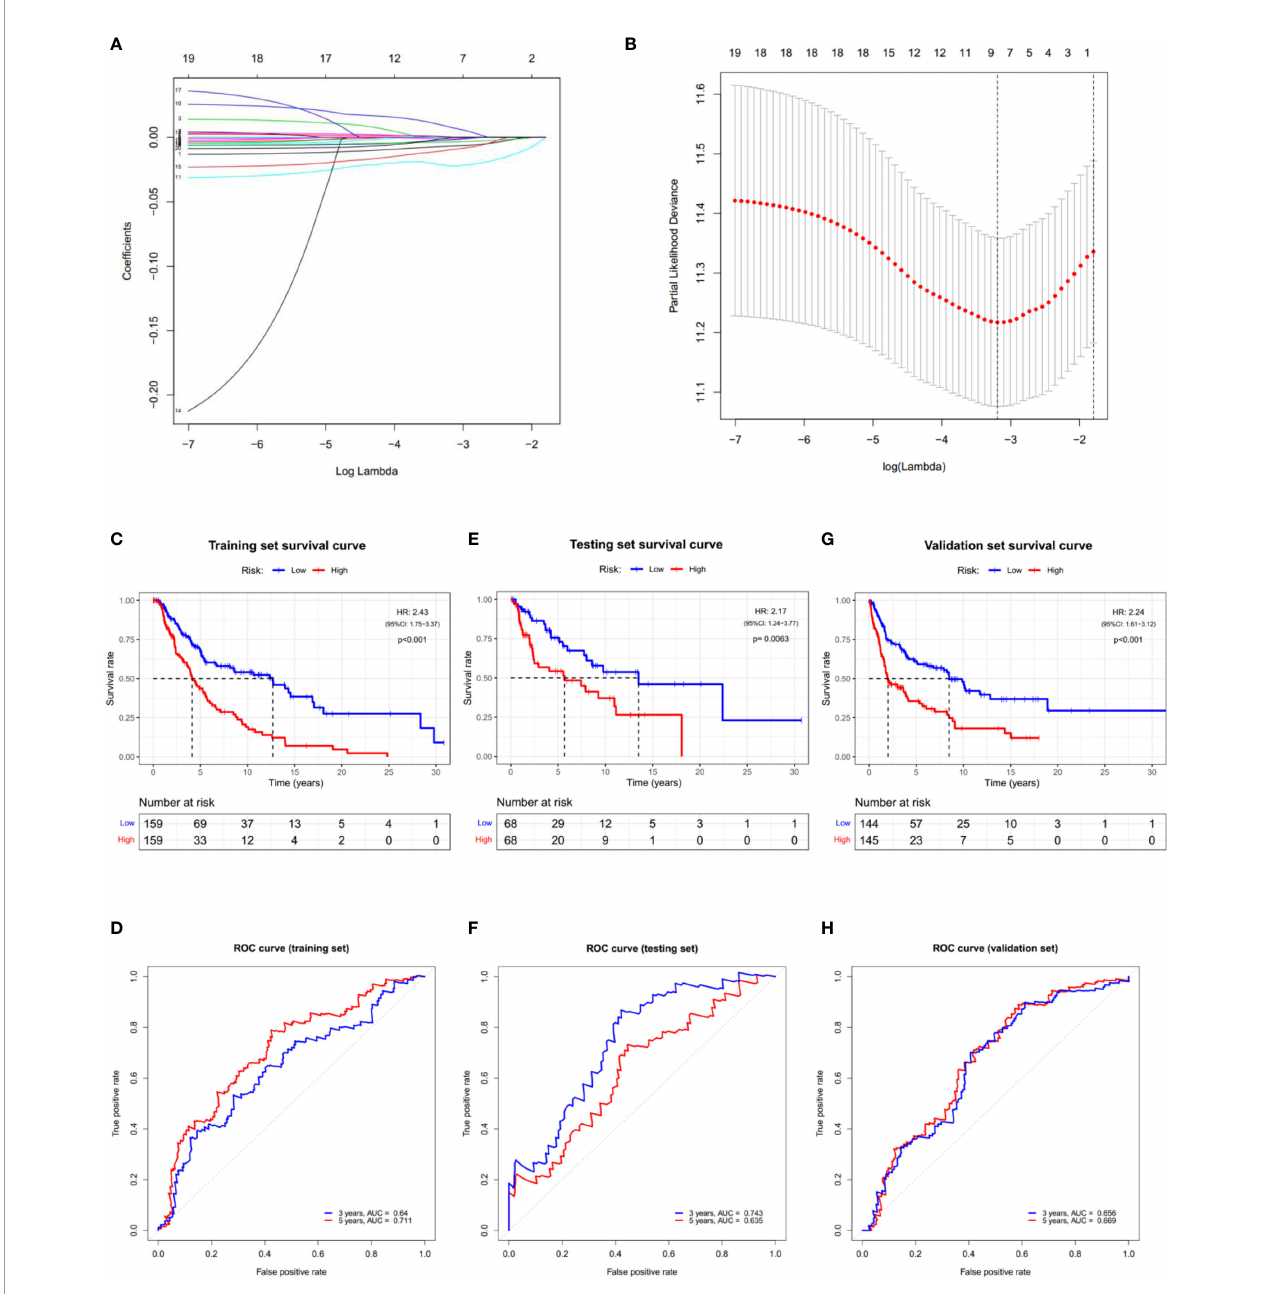
FIGURE 5 | Construction of the PRGs-based prognostic model. (A) LASSO regression of the 7 OS-related genes. (B) Cross-validation for tuning the parameter in the LASSO regression. (C – H) KM curves showing the OS of the low- (blue) and high- (red) risk subgroups. ROC curves demonstrated the predictive ef fi ciency of the risk score for 3- and 5-year survival. Data from TCGA-SKCM were randomly divided into a training set (C, D) and a testing set (E, F) according to 7:3. GSE54467 and GSE65904 were merged as the validation set (G, H) . HR, hazard ratio. CI, con fi dence